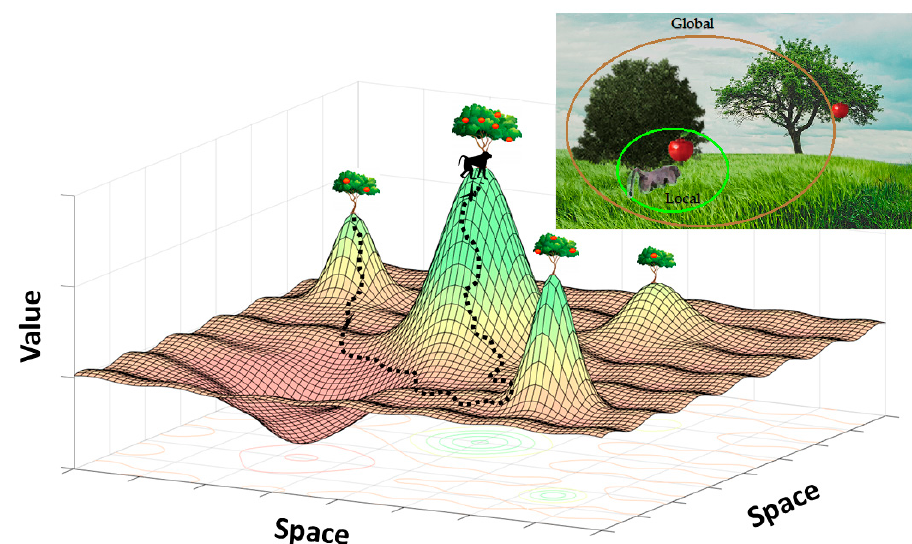
Figure 1. Environment Requiring Multiscale Processing. (Upper Right) For the animal at the tree in the front, the environment can consist of a local environment and a global environment. Its survival depends on its ability to process information at both local and global levels. For example, the larger environment may provide better opportunity for food sources and/or pathways for escape when predators appear. (Lower Left) The optimization process in machine learning and animals involves some sort of gradient ascent (or descent) where the state or agent follows the local gradient. This space can be considered continuous—Such as with “odor-scapes” of smell gradients—Or discrete—With different trees representing different patches, similar to multi-alternative choice environments (Upper right image adapted and modified with permission from Akaishi and Hayden, 2016, Neuron, Cell Press [35]).